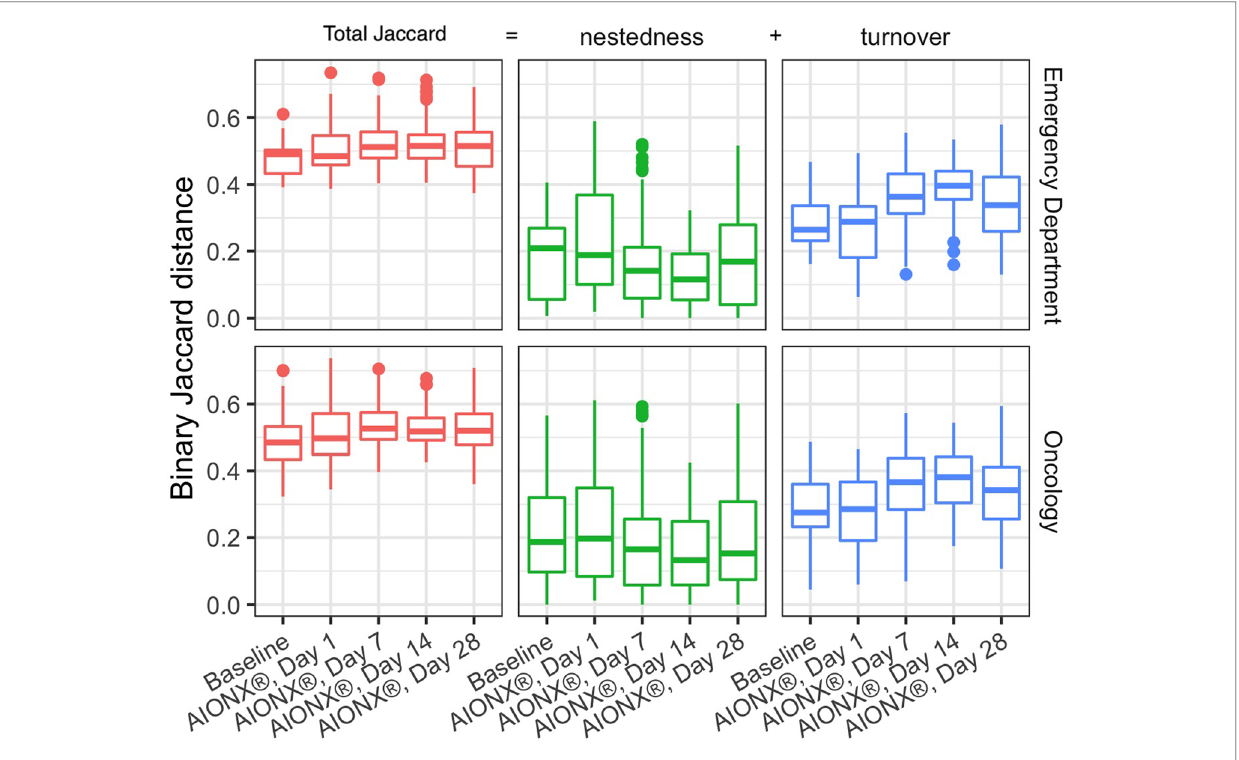
FIGURE 3 Comparisons of baseline samples to post AIONX ® intervention across emergency department and oncology ward. Binary Jaccard distances were partitioned into nestedness (species loss) and turnover (species gain) to explain their contribution to changes compared to baseline. Higher Jaccard distances indicate more dissimilarity in the microbial community where as lower Jaccard distances indicate more similarity in the microbial community. Turnover contributes more to Jaccard distances as compared to nestedness. Nestedness species loss stays relatively stable over time while turnover (species gain) increases over